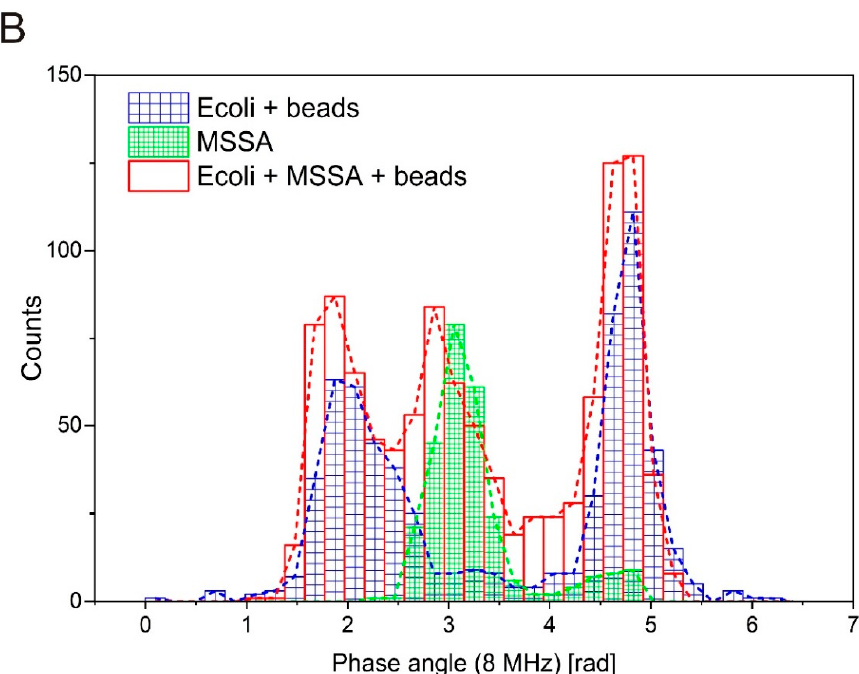
Figure 5. ( A ) Phase shift at 8 MHz plotted against the low frequency signal of the bacteria E. coli and S. aureus and polystyrene beads in diluted PBS ( B ) Histogram of the high frequency phase angle, clearly showing the two populations of bacteria.